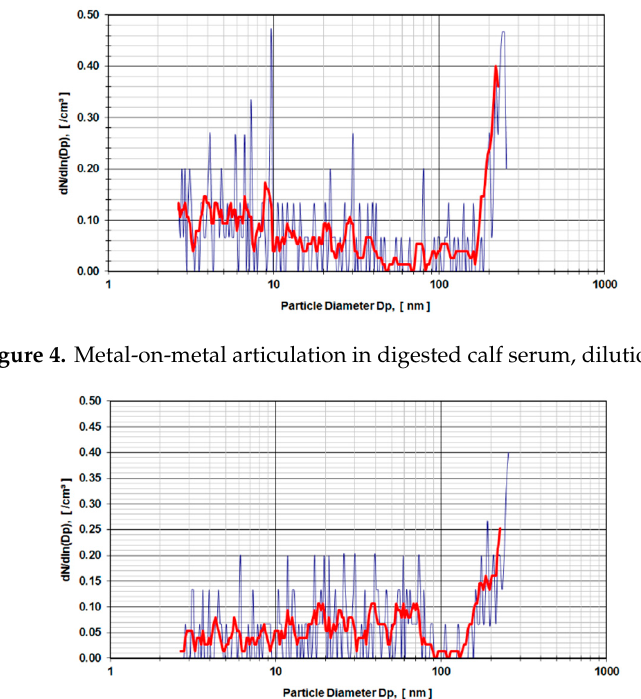
Figure 5. Calf serum without metal-on-metal articulation, digested, dilution